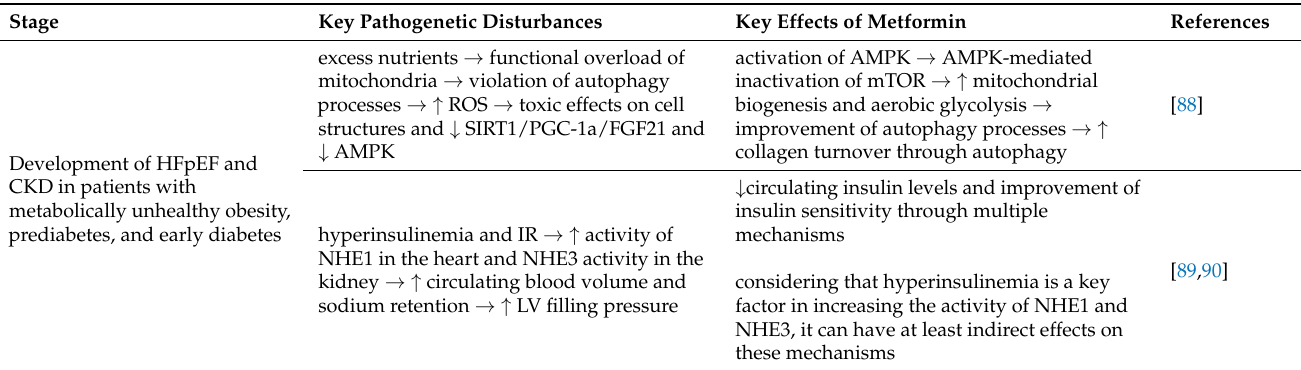
Table 2. Key effects of metformin at different stages of the cardiometabolic and cardiorenal contin-